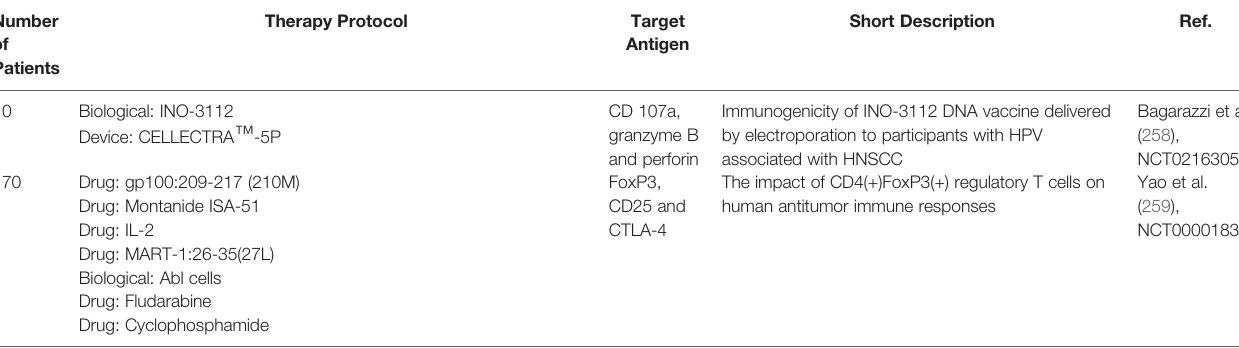
TABLE 1 | Summary of antigen loss or modulation found in published clinical